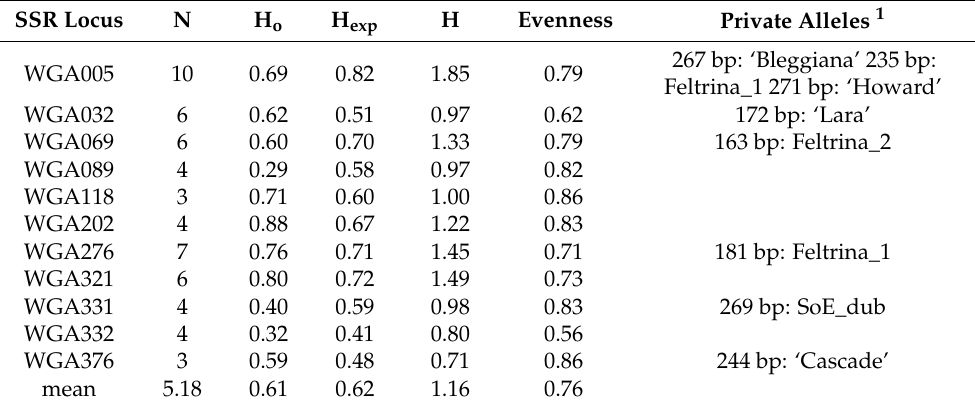
Table 1. Estimates of genetic diversity calculated for 11 SSR loci in 42 walnut genotypes. N: total number of observed alleles, H o : observed heterozygosity, H exp : expected heterozygosity, H: Shannon diversity index.